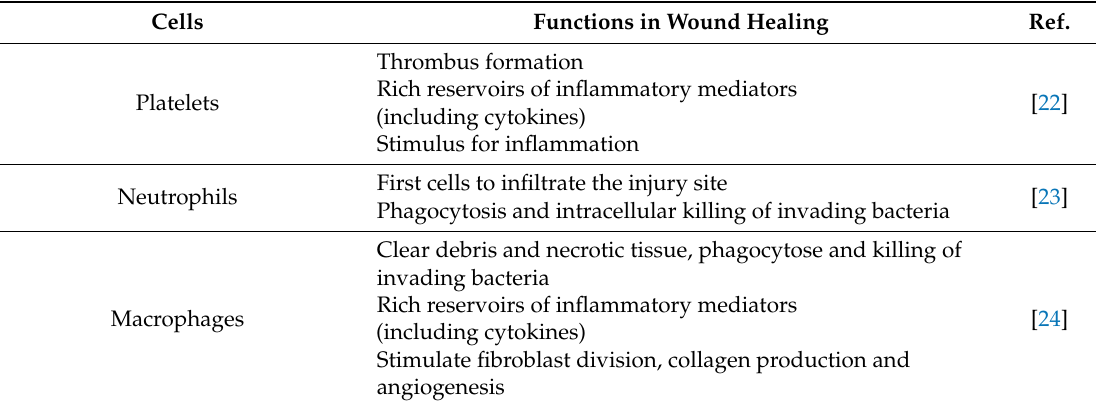
Table 1. Cells and Growth Factors Involved in Wound Healing Phases.